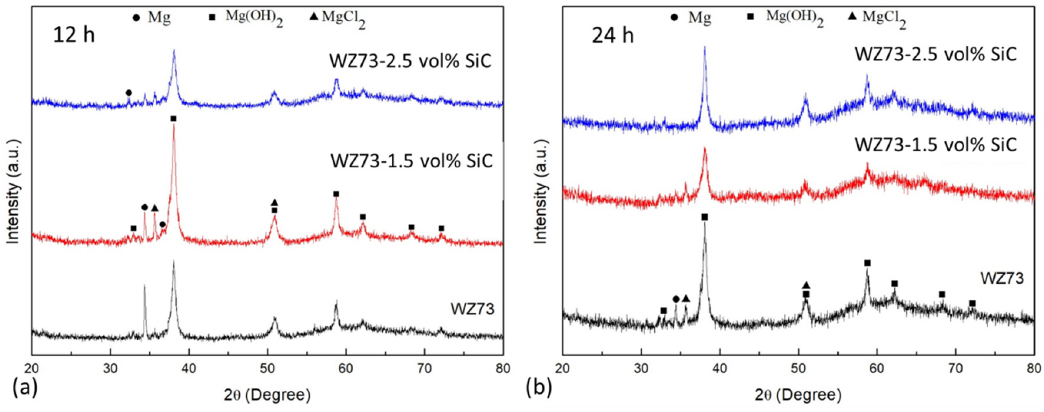
Figure 8. XRD patterns of the surface corrosion layers in WZ73 and MMCs after immersing in 1 wt % NaCl solution for ( a ) 12 h and ( b ) 24 h.